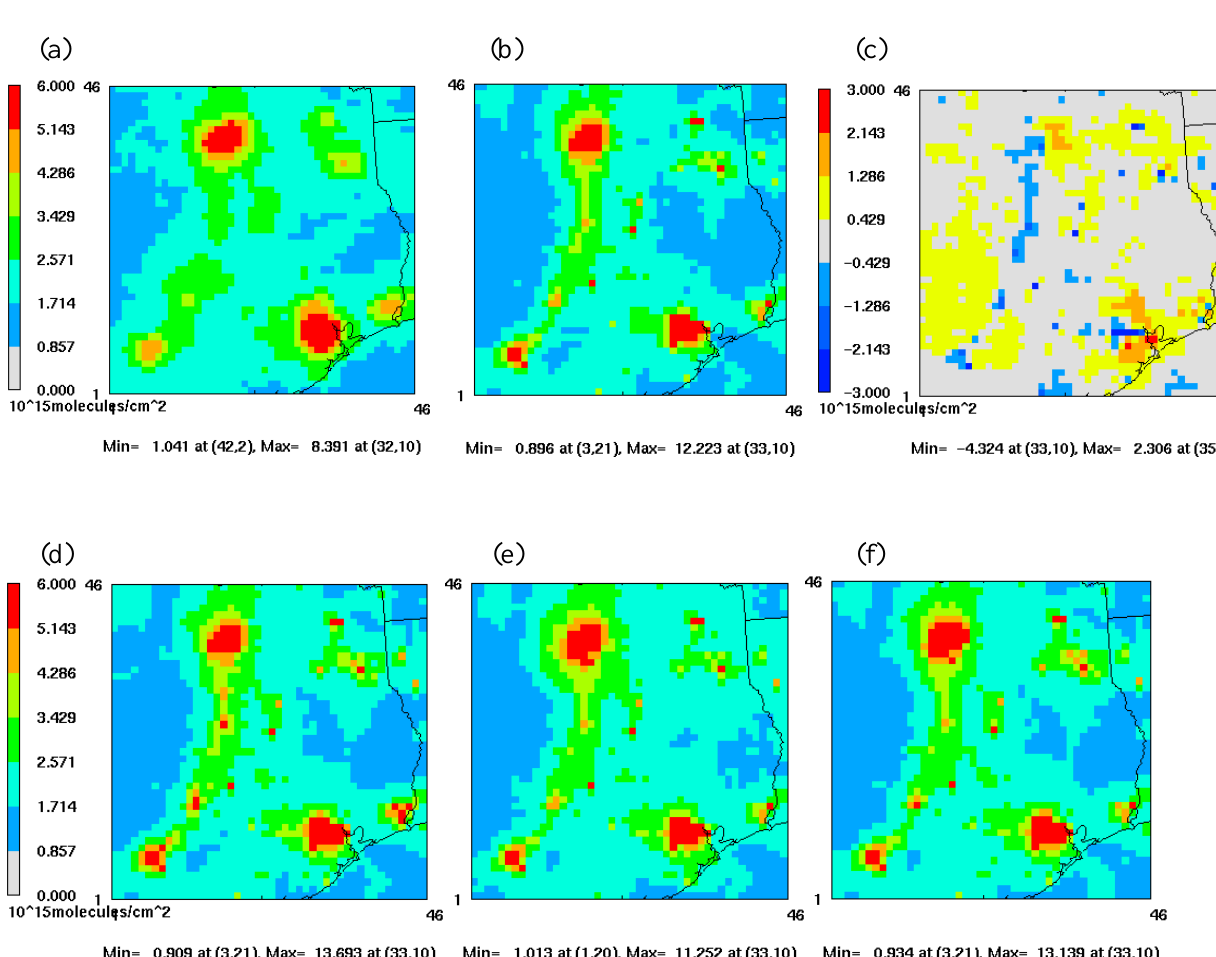
Figure 7. Comparisons of modeled NO 2 vertical distributions with INTEX NASA DC-8 flight (left) and TexAQS 2006 NOAA P-3 aircraft (right) measurements.